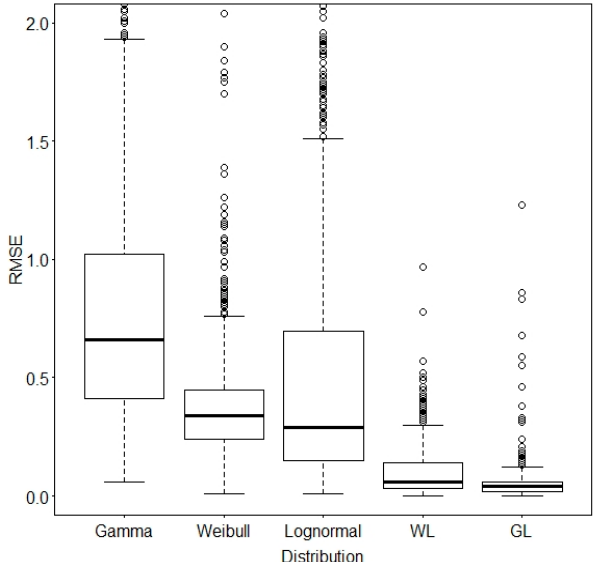
Figure 3. Root Mean Square Error (RMSE) of observed versus simulated rainfall using single and mixed distributions. The boxes represent the interquartile range (IQR), the dotted lines are extended to 1.5 times of IQR, the circles represent observations outside the dotted lines (extreme observations).